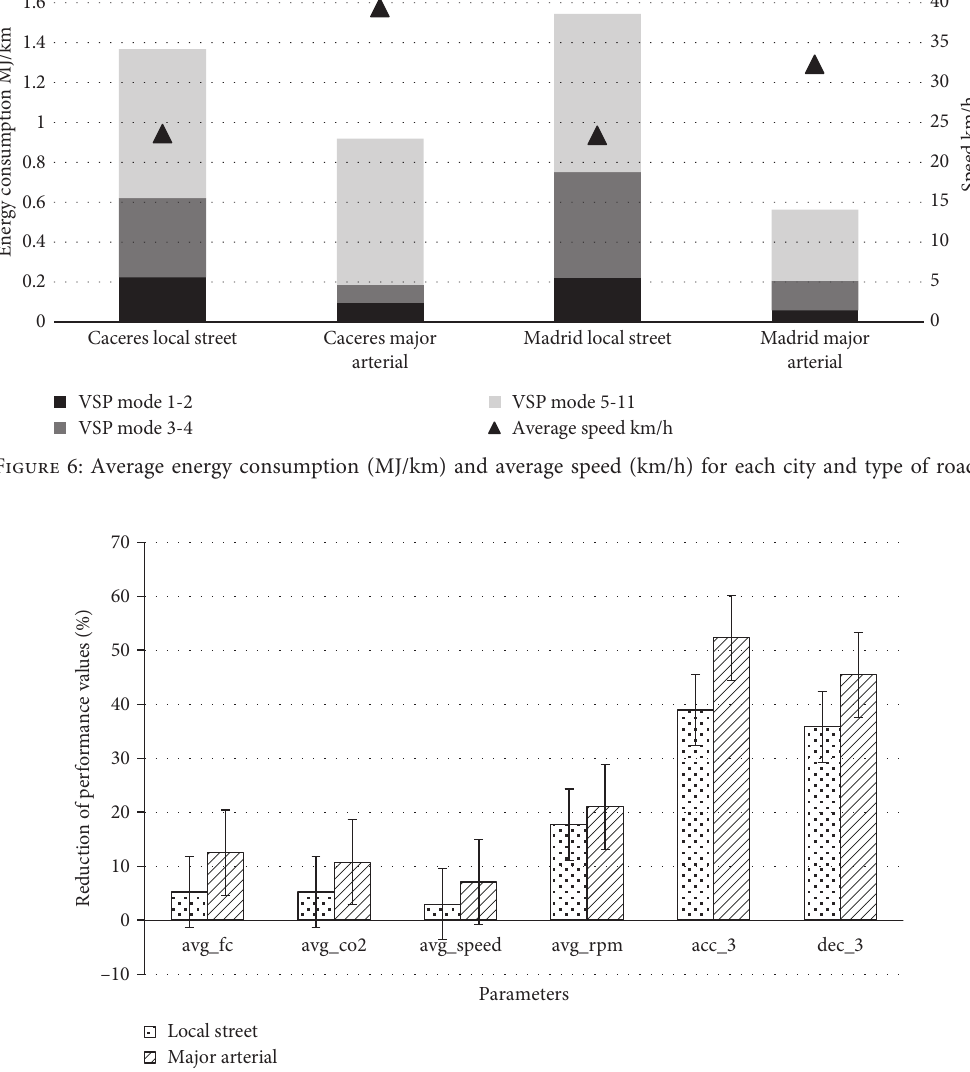
Figure 7: Effects of eco-driving training on traffic and emissions parameters.